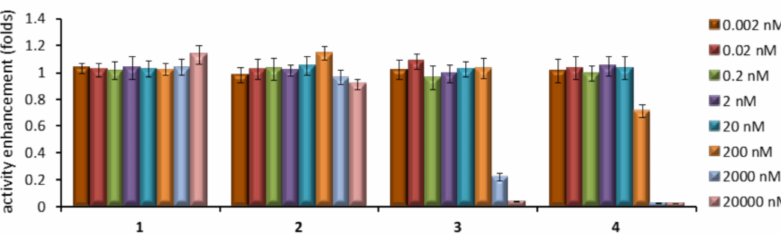
Figure 4. Effects of different concentrations of the sp 2 -iminosugar candidates 1 – 4 in the activity of GCase in cultured healthy human fibroblasts. Each bar represents the mean ± standard error (SEM) of three determinations each done in triplicate.